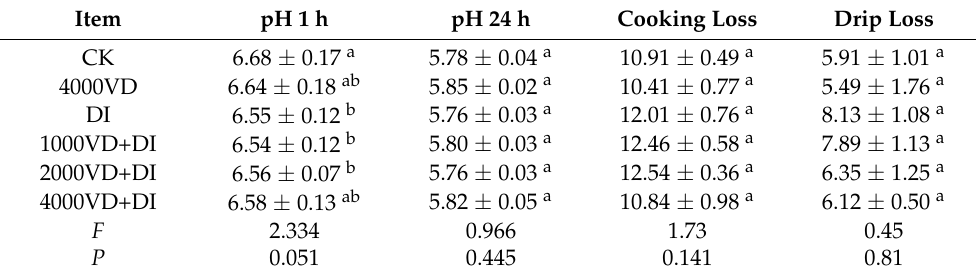
Table 5. Quality identification of the Wenchang chicken pectoral muscle.